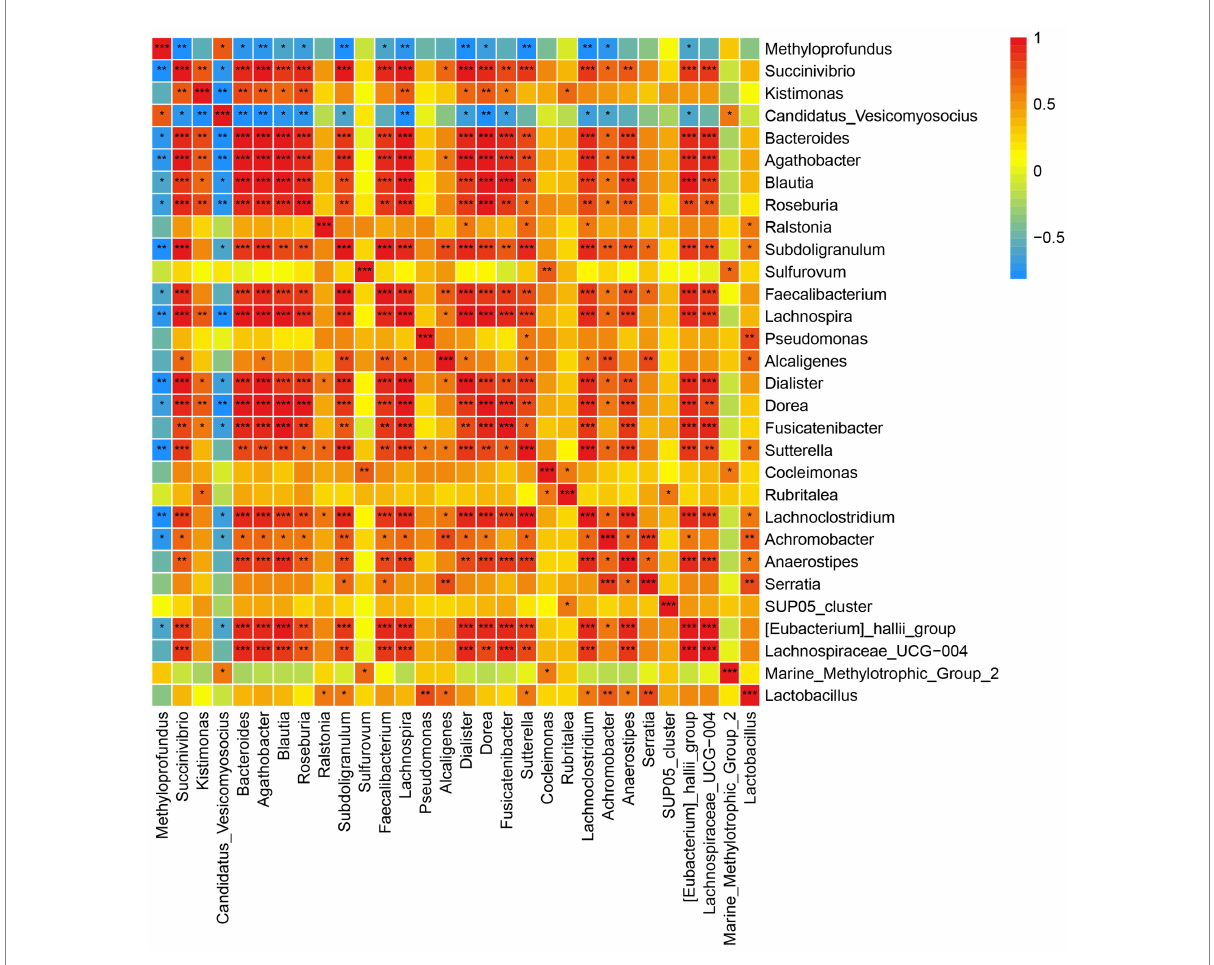
FIGURE 4 Correlation plot depicting microbe-microbe correlations. Color indicate the magnitude of the correlation, asterisks indicate significance of correlation (*** indicates p value <0.001 ** indicates q value <0.01 and *indicates q value